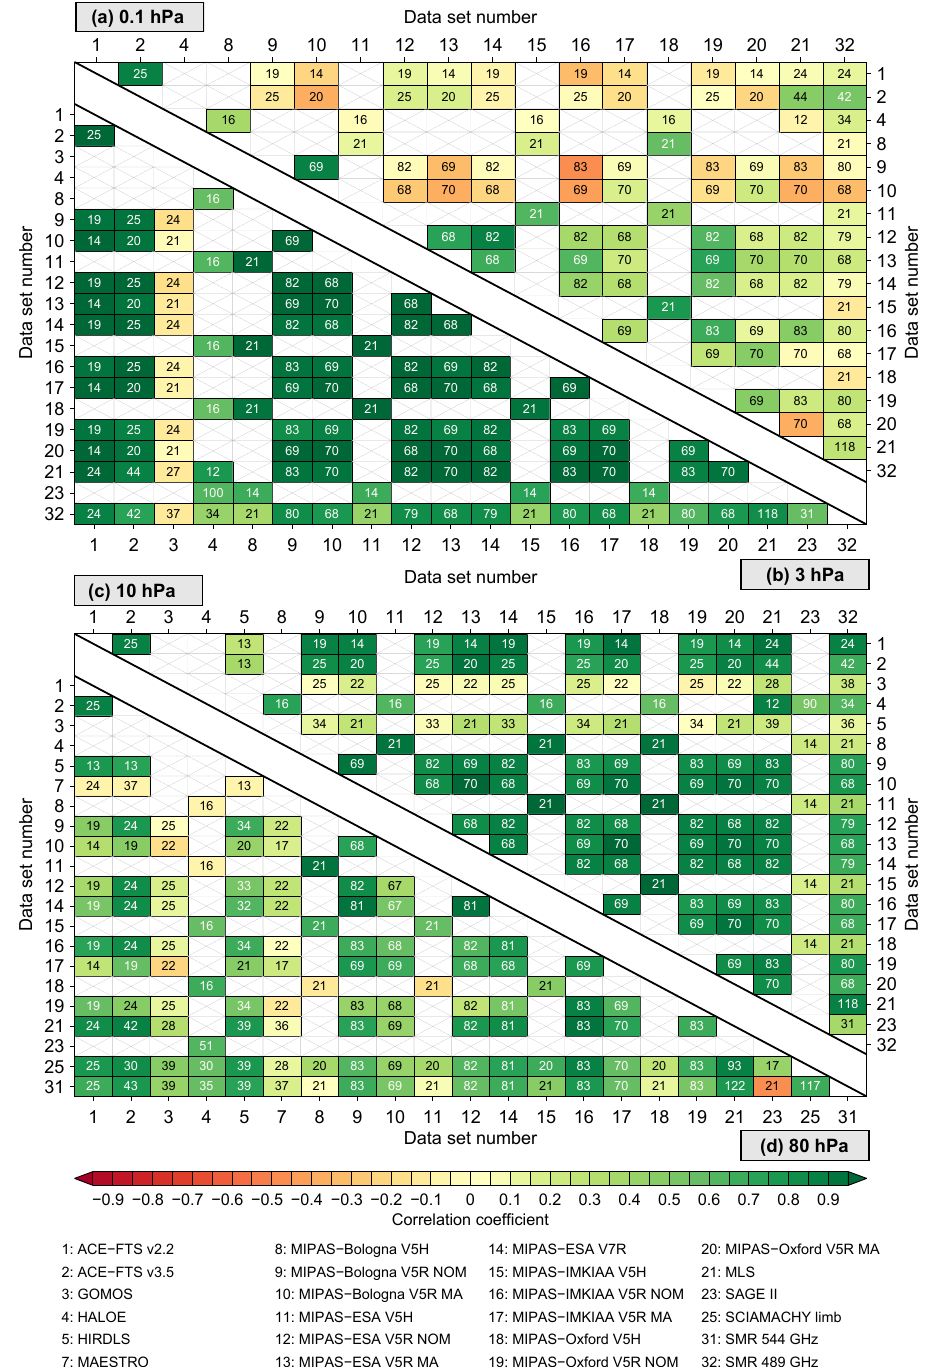
Figure 8. As Fig. 7, but here the results for the latitude band between 15 ◦ S and 15 ◦ N are shown.